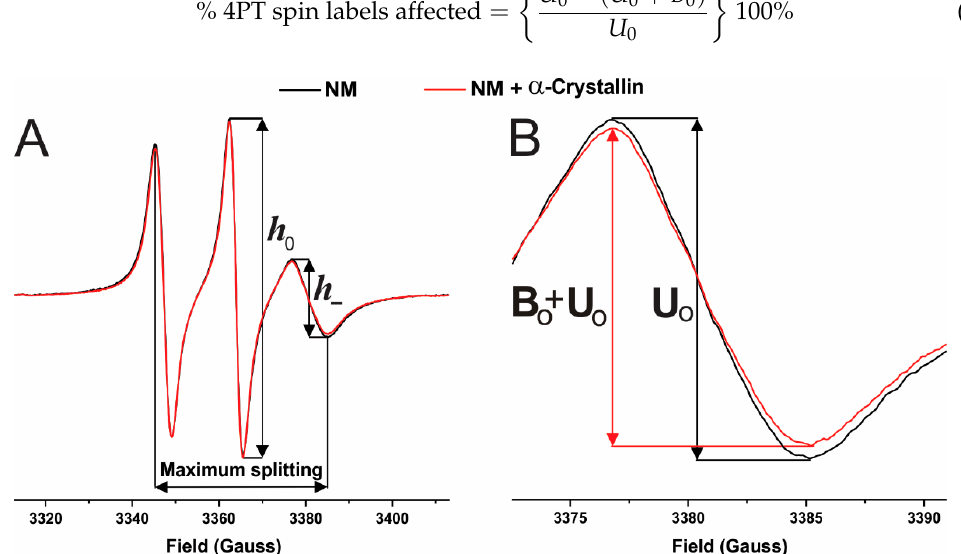
Figure 7. ( A ) The red and black spectra are the representative electron paramagnetic resonance (EPR) spectra of the 4PT in the bovine nuclear lens lipid membrane derived from a single lens with 52.6 μ M α‐ crystallin and without α‐ crystallin, respectively. The ratio of peak to peak height of the high field line (h − ) and the central line (h 0 ) of the EPR spectra gives the mobility parameter (i.e., h − /h 0 ) and the horizontal distance between the low field line and the high field line of the EPR spectra gives the maximum splitting. ( B ) It shows the zoomed high field lines of the spectra displayed in ( A ). The unbound ( 𝑈 (cid:2868) ) and unbound plus bound ( 𝑈 (cid:2868) + 𝐵 (cid:2868) ) contributions are used to calculate the percentage of membrane surface occupied (MSO) by α‐ crystallin and the binding affinity (K a ). DLS measurements on a DynaPro instrument (Wyatt Technology Corp., Santa Bar ‐ bara, CA, USA) using regularization methods (Dynamics software, version 7) gave the size of the cortical and nuclear uni ‐ lamellar vesicles to be ~120 nm. Based on that, ~52% and ~48% of the 4PT molecules are on the outer and inner surfaces of the membrane, respec ‐ tively. Since the 4PT spin ‐ labels that are on the outer surface are only affected by the bind ‐ ing of α‐ crystallin, the corrected percentage of 4PT spin label affected or the percentage of membrane surface occupied (MSO) by α‐ crystallin is estimated as: (cid:4673) % membrane surface occupied (MSO) = (% 4PT spin labels affected) (cid:4672) (cid:2869)(cid:2868)(cid:2868) (cid:2873)(cid:2870)